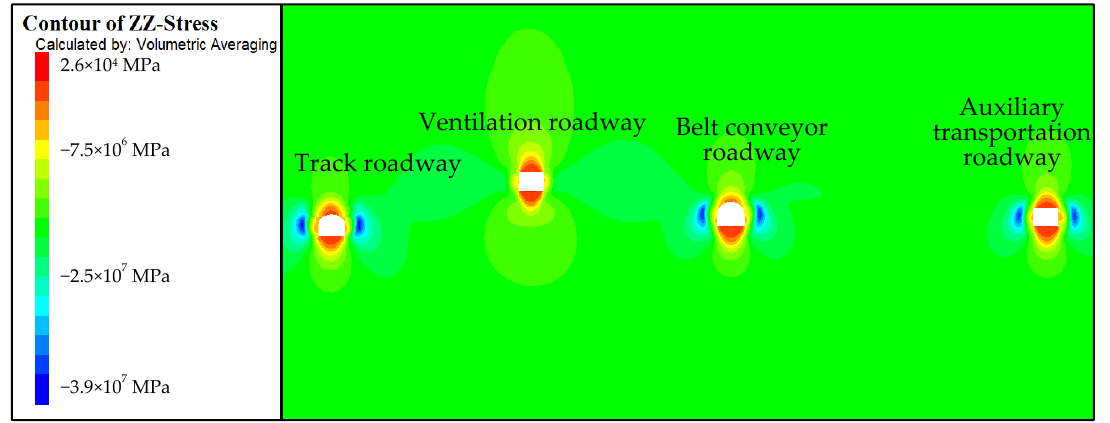
Figure 9. Vertical stress distribution of surrounding rock behind excavation of roadway group.